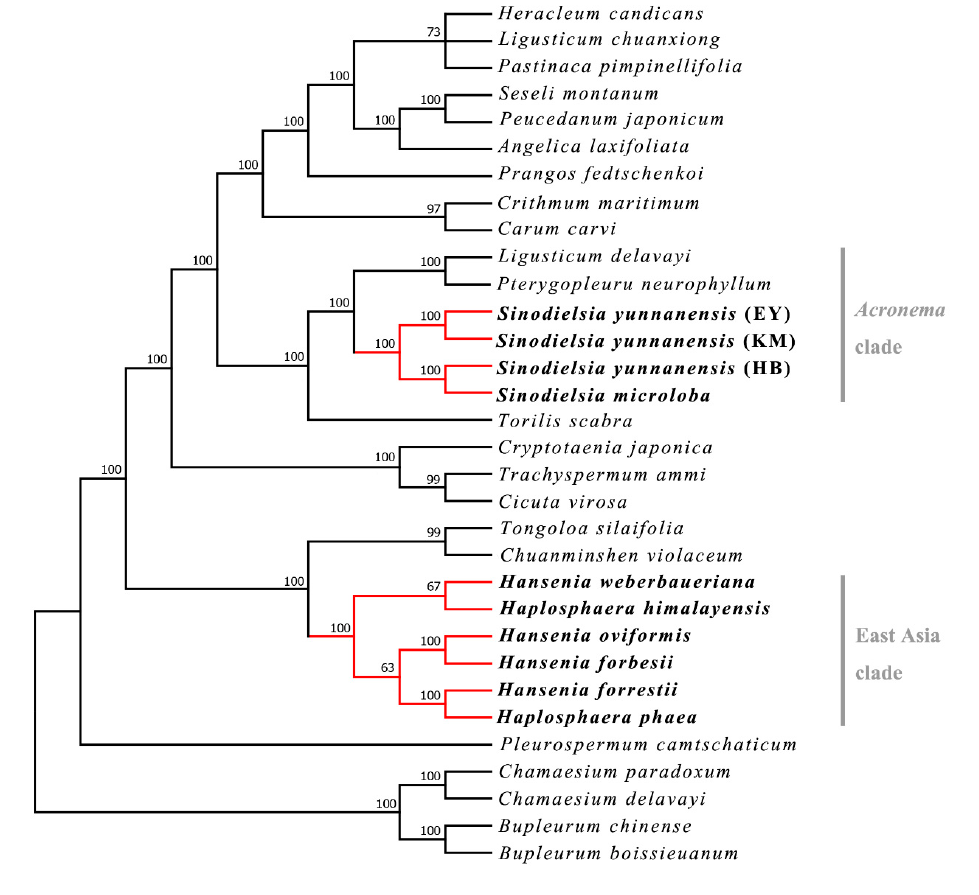
Figure 2. Maximum Likelihood (ML) phylogenetic tree of Apiaceae using the 32 plastid genomes dataset. The studied taxa are bold. The numbers above the nodes are Maximum Likelihood-Bootstrap Support (ML-BS) presented as percentages ( > 50%). The names of the clades follow the study of Zhou et al.